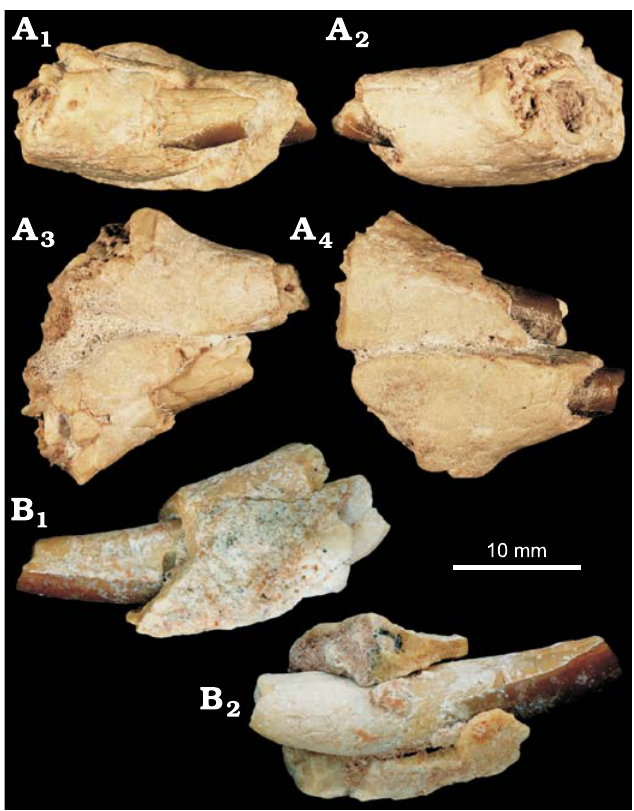
Fig. 6. Lower incisors of multituberculate mammal Sphenopsalis nobilis Matthew, Granger, and Simpson, 1928 from the upper Paleocene Nomogen beds at the Erden (Urtyn) Obo locality, Inner Mongolia, China. A . IVPP V19025, symphysis of mandibles with partial incisors in lateral right (A 1 ) and left (A 2 ), dorsal (A 3 ), and ventral (A 4 ) views. B . IVPP V19034, right incisor in medial (B 1 ) and lateral (B 2 )